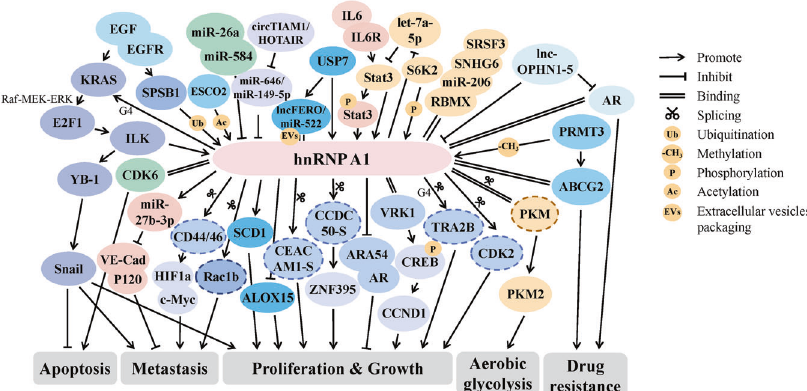
Fig. 2 Simpli fi ed molecular regulatory networks of hnRNPA1 in cancer. The network of hnRNPA1 modulating cancer development are complex, regulating splicing, transcription, maturation, translation or EVs packaging. Additionally, the expression of hnRNPA1 could be in fl uenced by certain upstream factors and post-translational modi fi